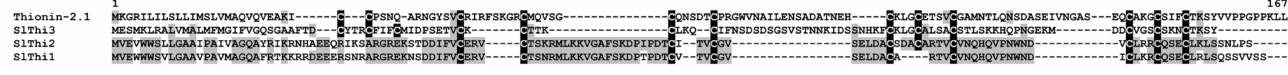
Figure 6. Multiple sequence alignment of S. lycopersicum thionin precursors and Arabidopsis thaliana thionin-2.1 (NP_565038.1). Cysteine residues are shaded black, and identical amino acids are shaded